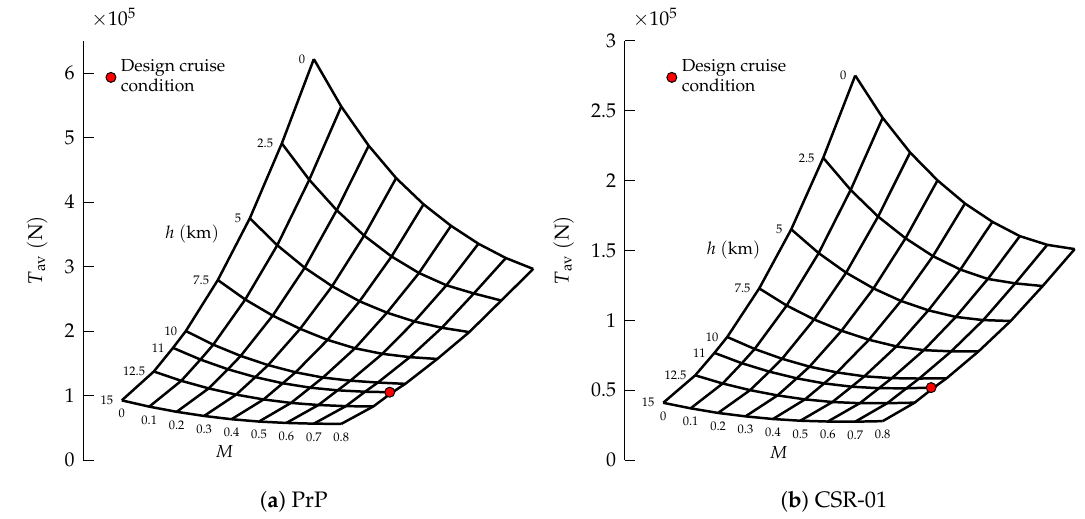
Figure 3. Maximum available thrust carpet plots for the ( a ) PrP and ( b ) CSR-01.